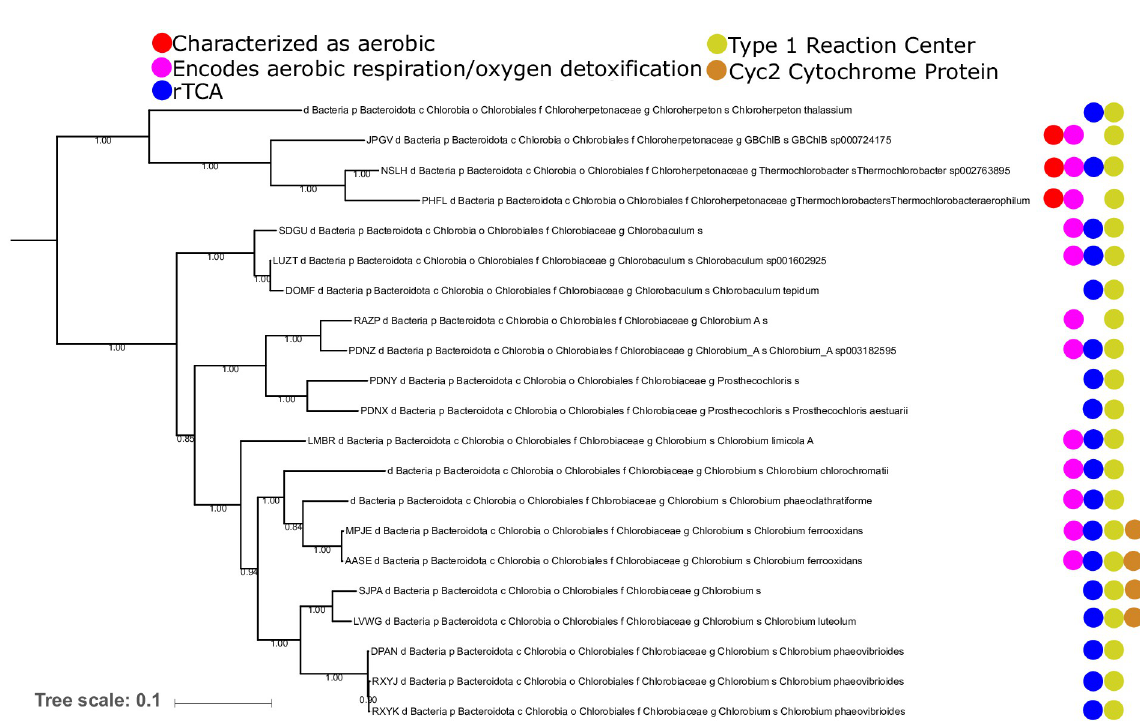
Fig 2. Phylogeny of the Chlorobia built with concatenated ribosomal proteins, with taxonomic assignments from GTDB-Tk and the presence of metabolic traits discussed in the text mapped on. The presence of a Type 1 phototrophic reaction center is ubiquitous within the Chlorobia class, but other traits (such as the presence of a Cyc2 cytochrome protein associated with iron oxidation) have a more limited phylogenetic distribution and may be more derived traits that were acquired after the radiation of the phylum.